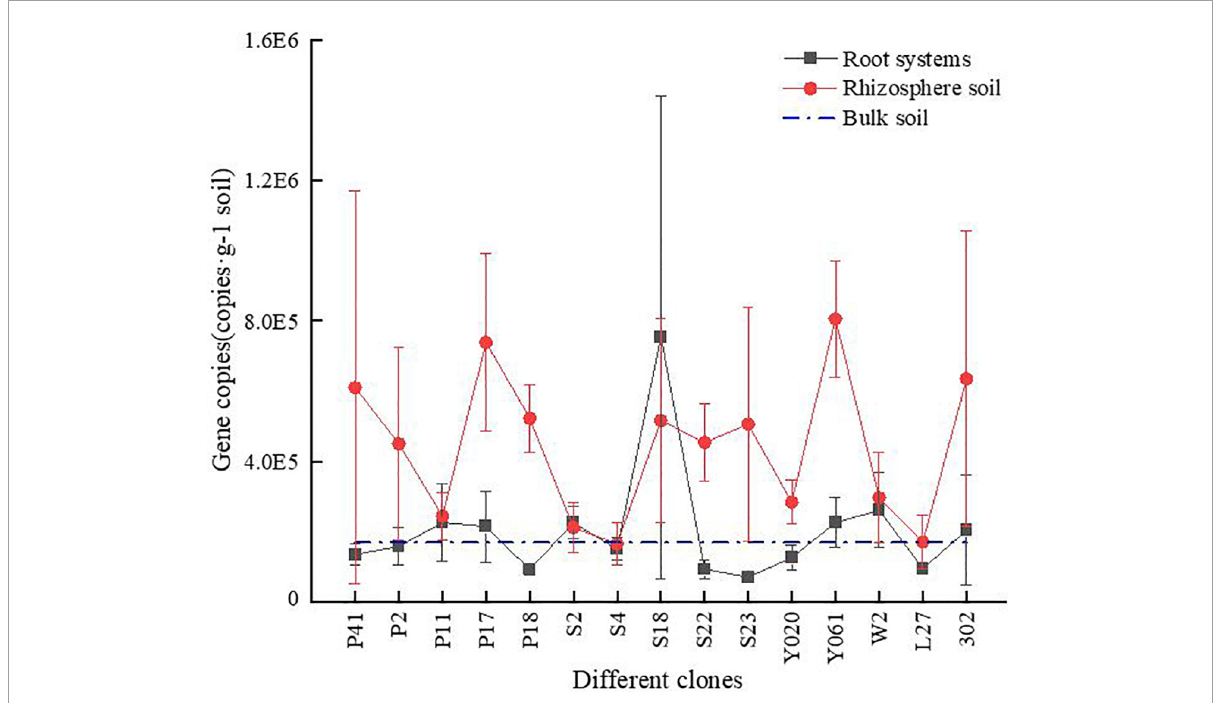
FIGURE2 The gene copies of AMF in different clones of Chinese fir plantations at different sampling positions. On the horizontal axis, S-NR represents bulk soil, R-represents root system, S-represents rhizosphere soil, and the subsequent number indicates clones.